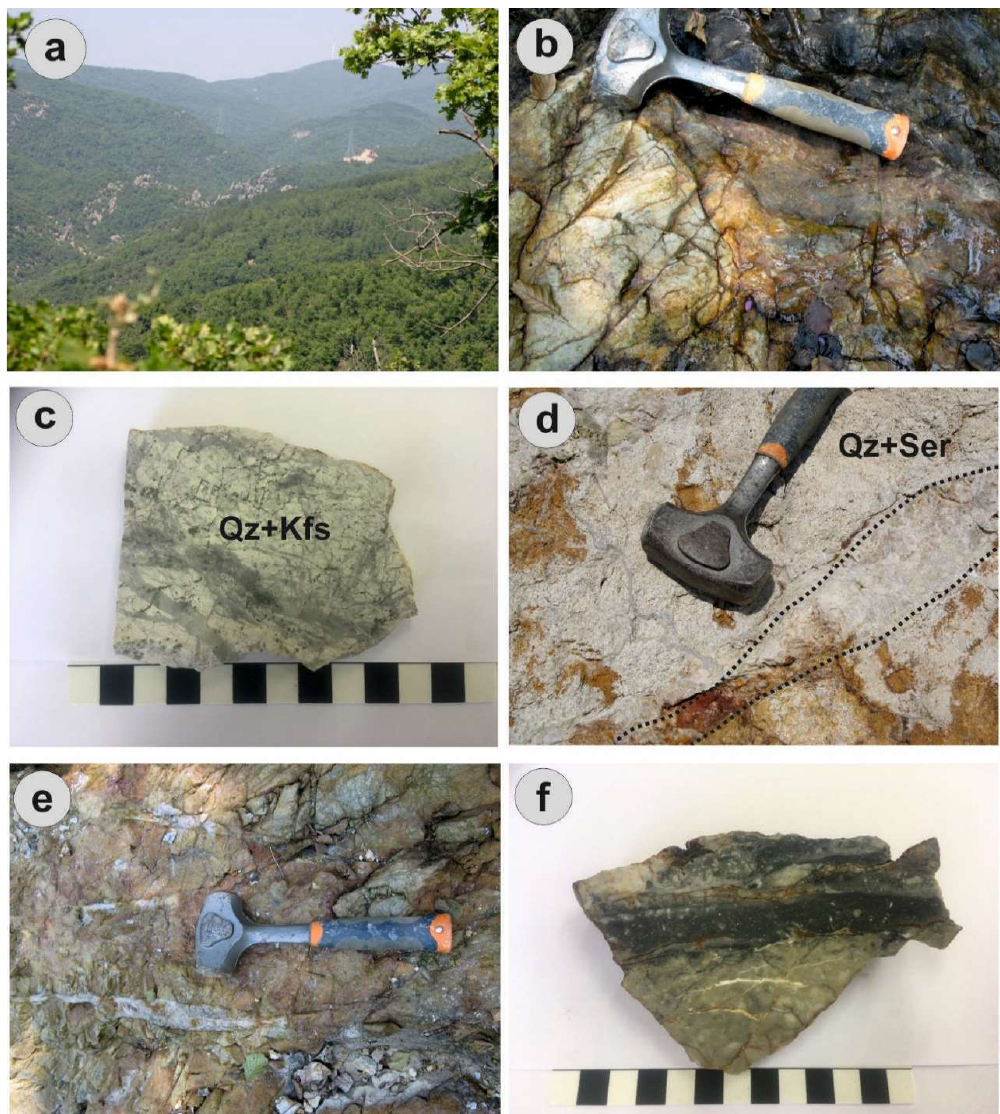
Figure 3. ( a ) The Aisymi-Leptokarya porphyry Mo prospect (view from S to N); ( b ) porphyry-style quartz stockwork veins within the potassic/sodic-altered microgranite; ( c ) hand-specimen of quartz porphyry stockwork (A-type veins) in potassic (Kfs-K. Feldspar) altered microgranite (sample EG3); ( d ) D-type vein (marked by the dotted line) associated with sericitic alteration (Ser), crosscutting earlier, A-type veins (bottom left); ( e ) milky quartz base metal veins (E-type) crosscutting earlier formed porphyry veinlets; ( f ) hand-specimen of base metal vein in silicified microgranite (sample EG29). The felsic dike complex consists of a major NW trending intrusive body, up to hundreds of meters wide and several km long, which crosscuts all the other rocks in the area (Figure 2). Alfieris et al. [26] described acid dikes (e.g., quartz ± biotite porphyries) from the south-eastern part of the study area, with disseminated pyrite and base metal veins mineralization.